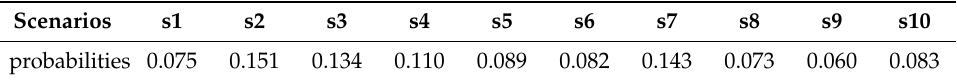
Table 4. The probabilities of reduced scenarios in Case